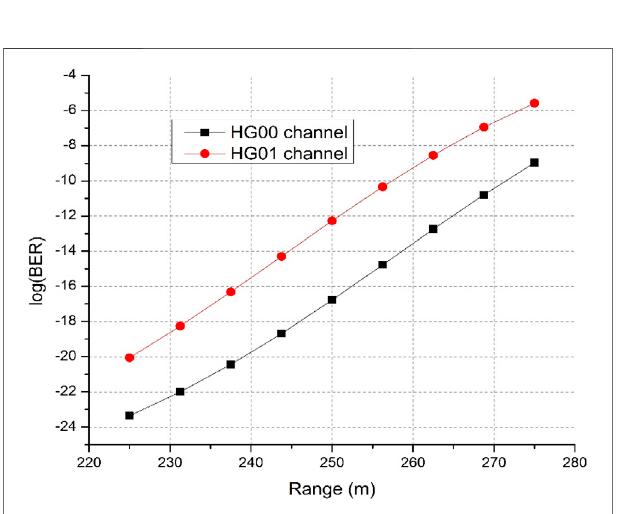
FIGURE 9 | log (BER) v/s transmission distance under moderate dust conditions.